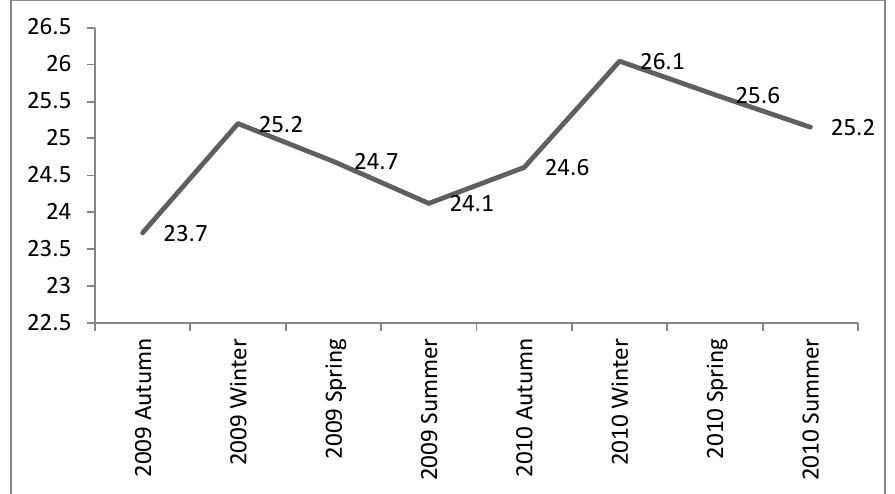
Figure 3. The mean BMI of participants in 2009 and